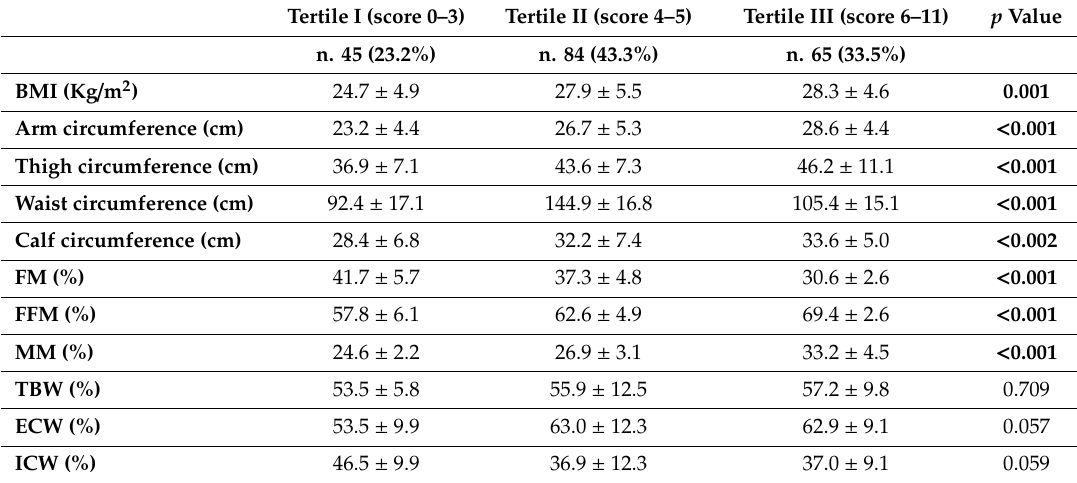
Table 4. Anthropometric measures and bioimpedentiometric parameters in patients at baseline, according to study groups.